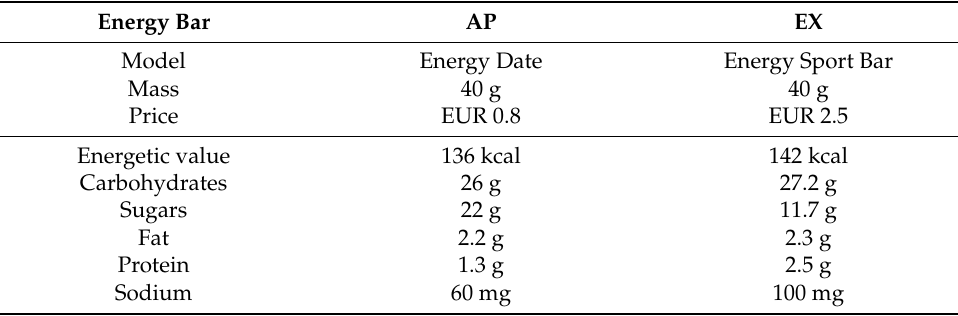
Table 1. Nutritional information of the bars: Aptonia (AP) and Etixx (EX).